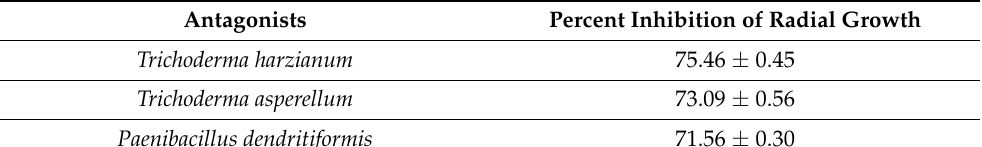
Table 1. The effects of T. harzianum , T. asperellum, and P. dendritiformis on the percent inhibition of radial growth of C. truncatum (values are the average of three replicates ± SEM).